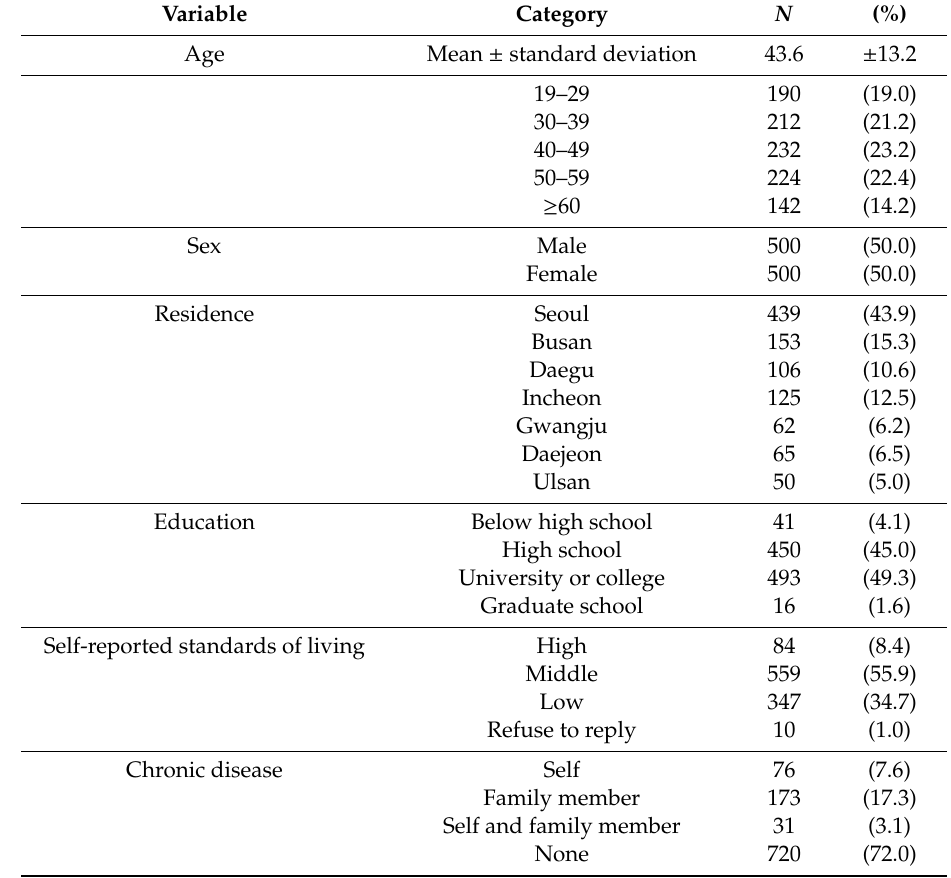
Table 2. General characteristics of the participants.